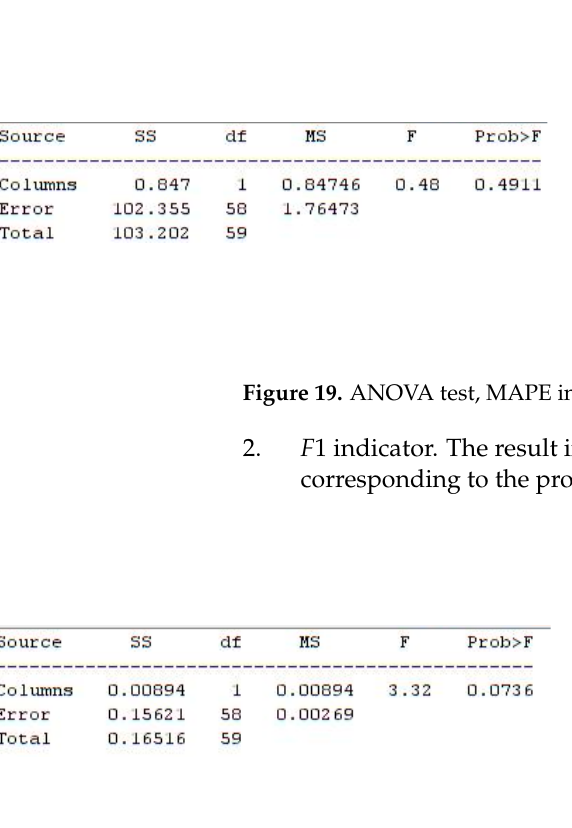
1. MAPE indicator. The result indicates a similarity between the MAPE values.